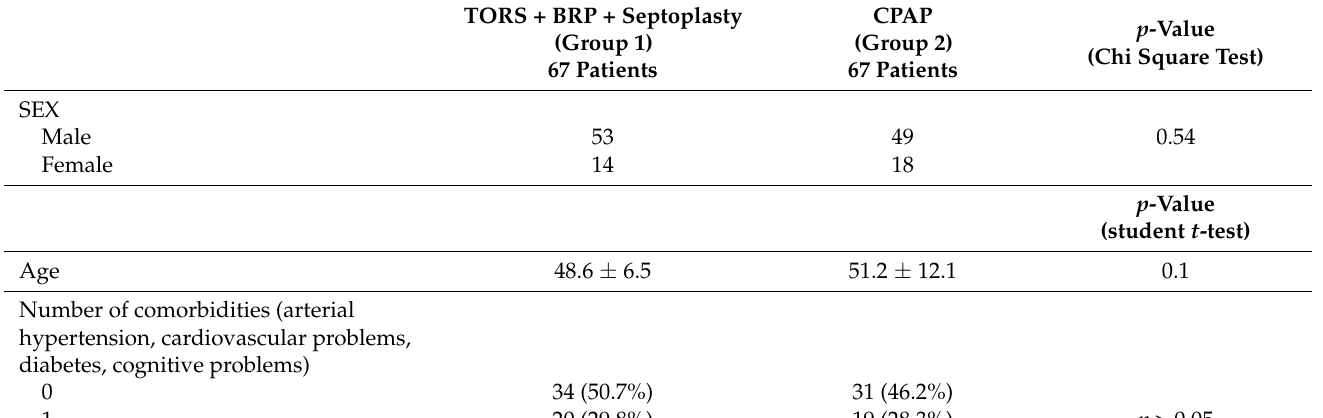
Table 1. Clinical characteristics and comorbidities of the two groups enrolled in the study.